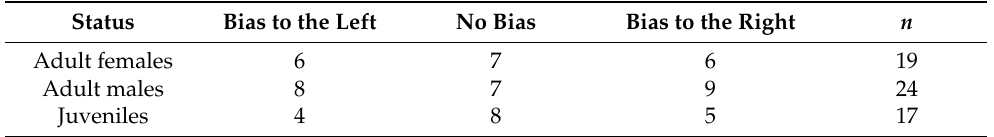
Figure 6. Frequency distribution of average head orientation during sentinel bouts in juvenile and adult Florida scrub-jays ( n = 60). Table 1. Statistically significant departures from the null expectation that average head orientation is equal to 0 ◦ for each status of Florida scrub-jay sentinels ( n =